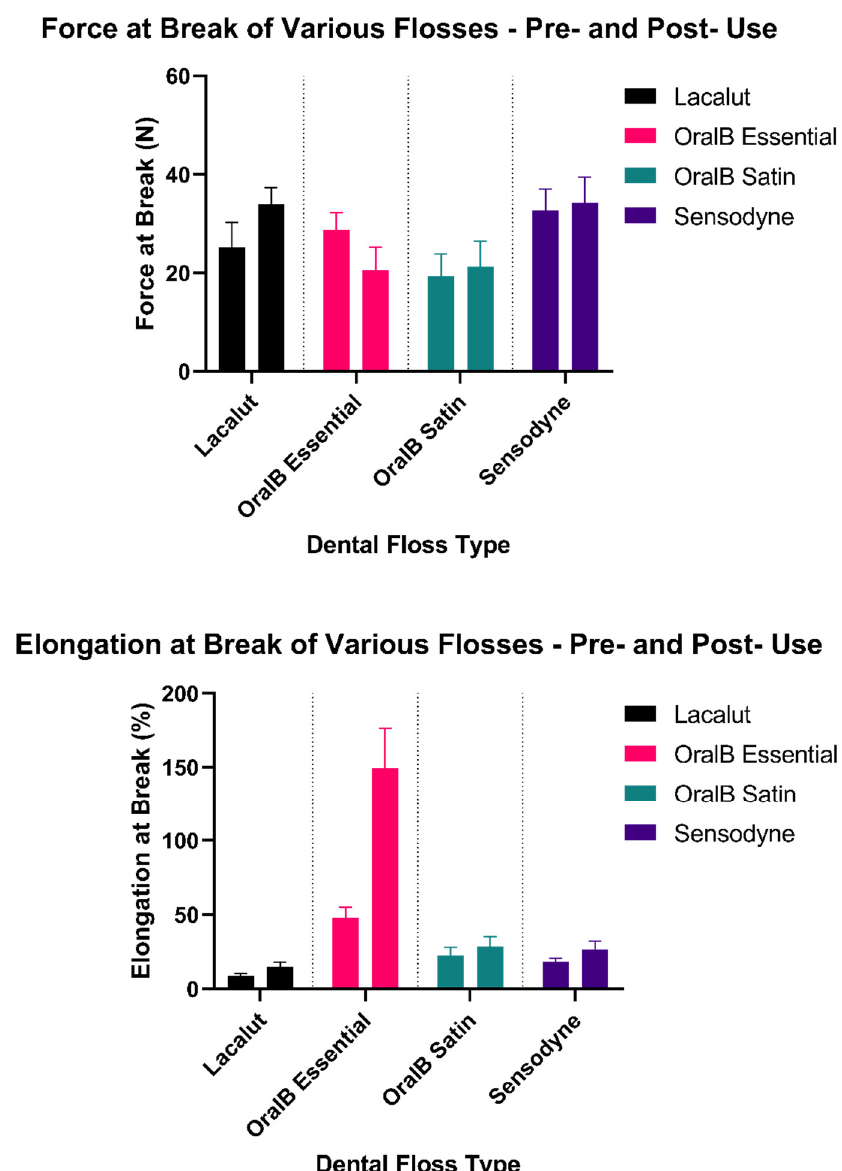
Figure 4. Force and elongation at break of dental flosses, mean values with standard deviation indicated. Left columns correspond to before and right columns to after usage.